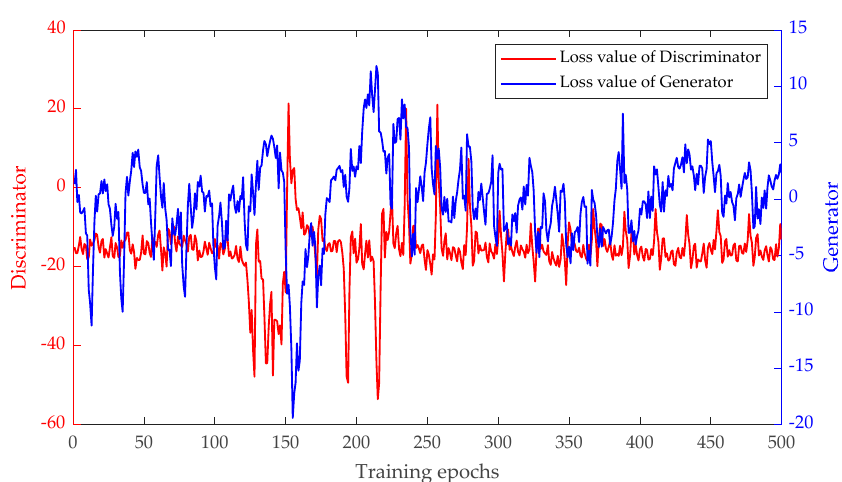
Figure 10. Loss values of the Generator and Discriminator during training.